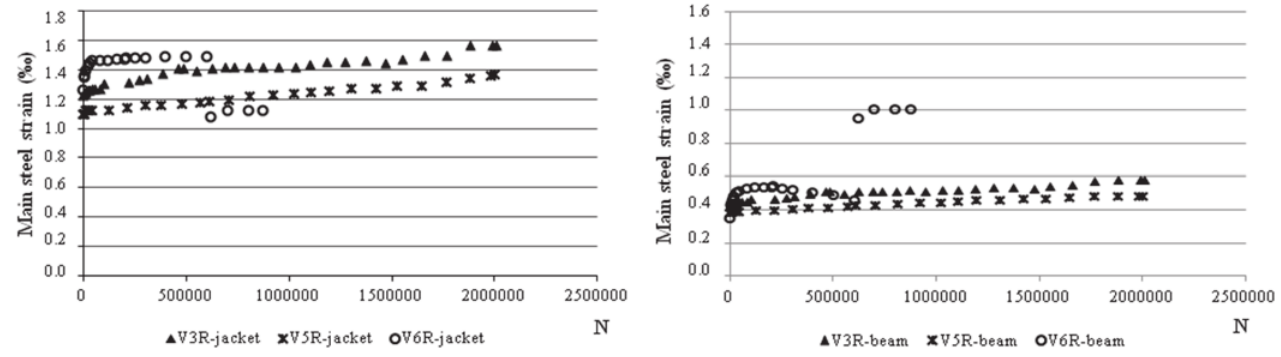
Maximum main steel strain of jacket and beam, at midspan, as a function of the number of cycles of beams with same reinforcement ratio, with rough (V3R) and smooth interface (V5R and